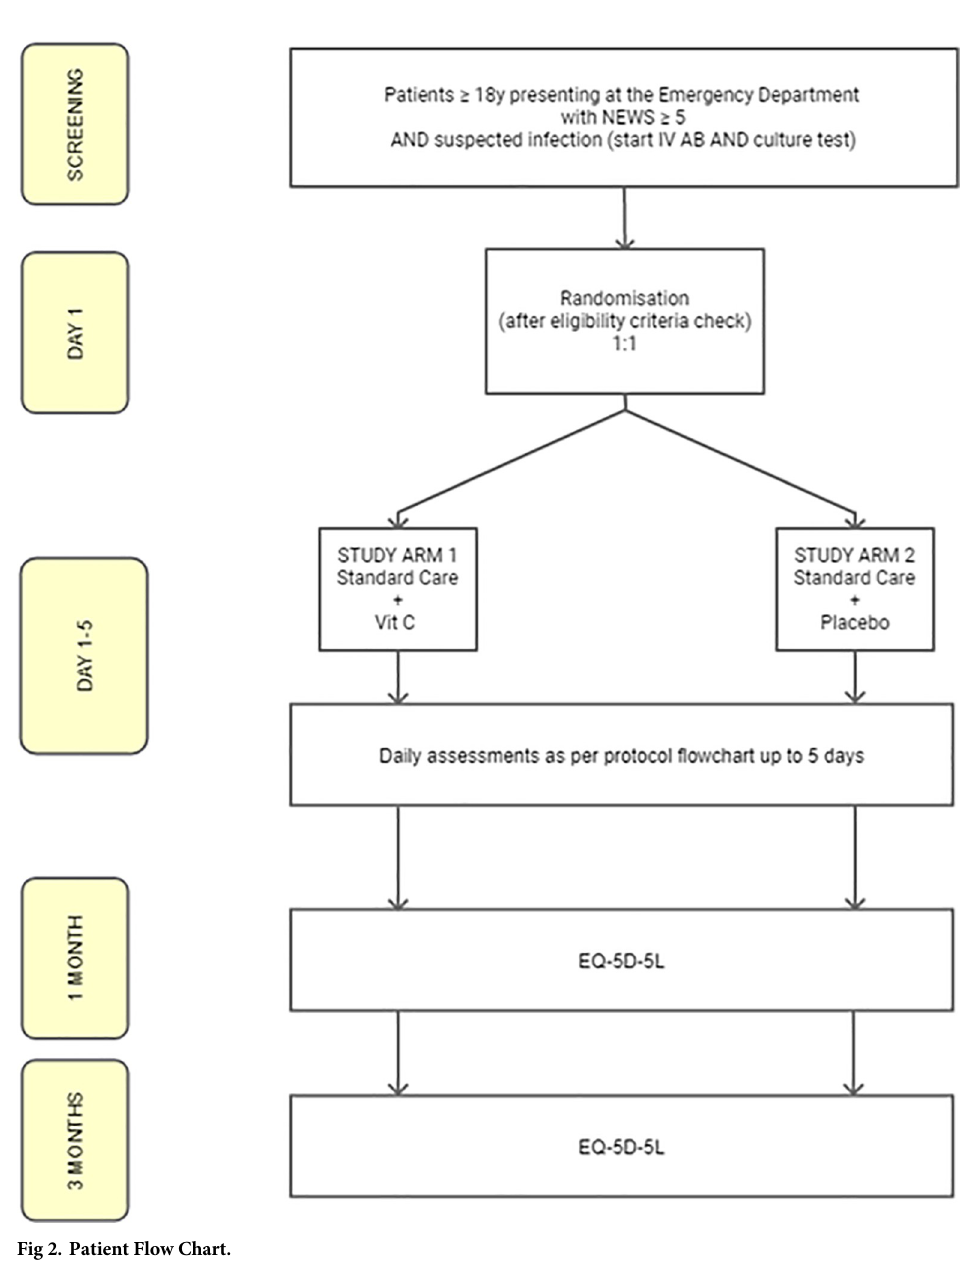
Fig 2. Patient Flow